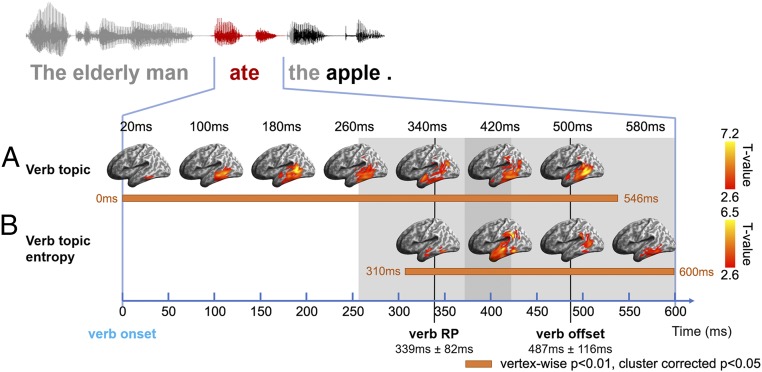
ssRSA results of model RDMs during the verb epoch (aligned to verb onset, extending 600 ms afterward to cover 1 SD of verb duration). (A) Verb topic RDM that captures verb semantics. (B) Verb topic entropy RDM modeling the strength of a verb’s semantic constraints. Significance was determined by 5,000 nonparametric permutations with vertex-wise P < 0.01 and cluster-wise P < 0.05. Horizontal orange bars indicate periods during which different model RDMs showed significant effects. Gray shading indicates the range of 1 SD for verb RP and verb offset.